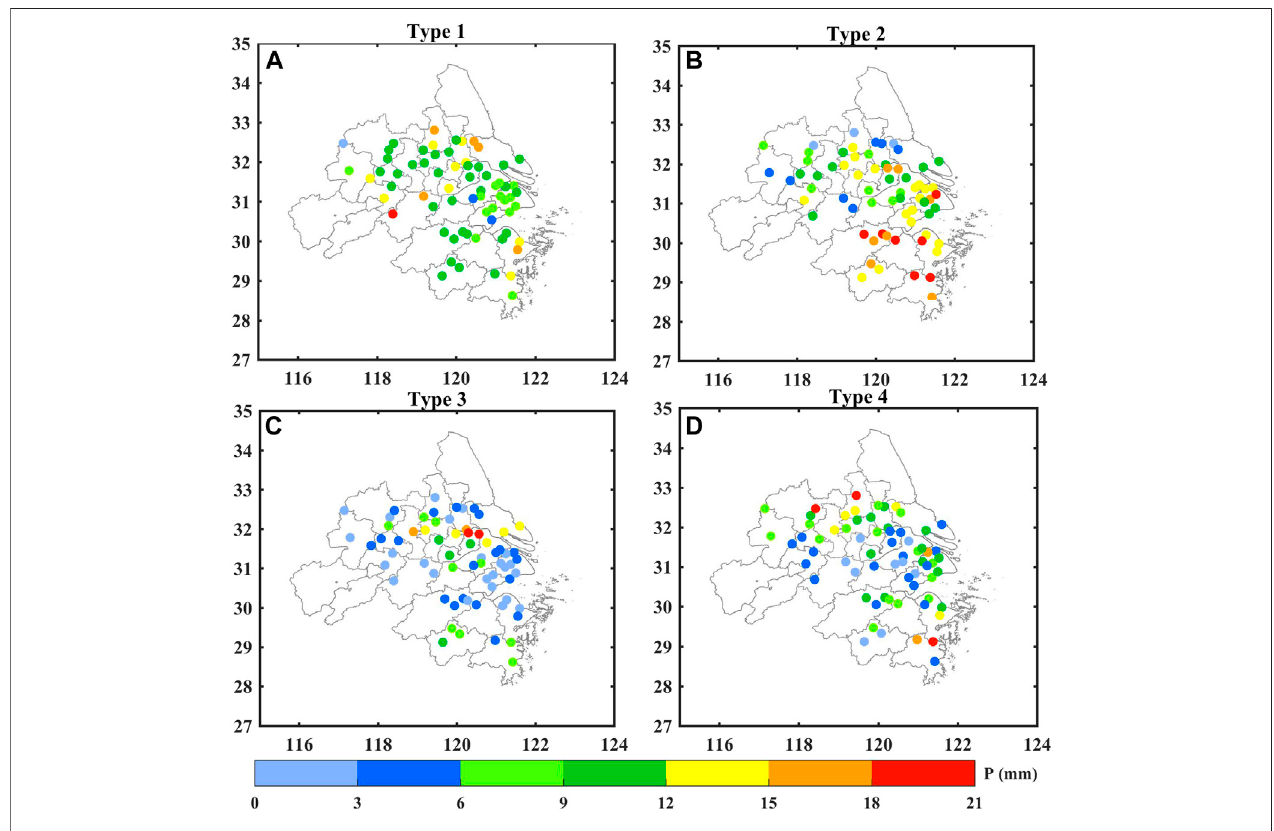
FIGURE 13 | As in Figure 9 but for mean